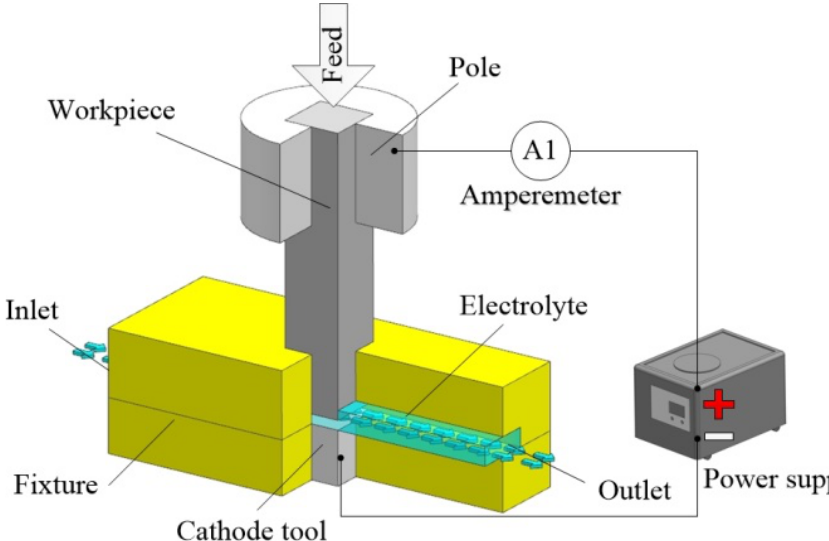
Figure 1. Schematic diagram of the conventional constant voltage method. During the measurement, the high-velocity electrolyte is pumped into the inter- electrode gap, so that bubble and Joule heat can be quickly removed to ensure the purity of the electrolyte. The tool and workpiece are connected to the cathode and anode of the power supply, respectively. The power supply outputs a constant voltage. The current distribution on the anode workpiece can be assumed as uniform based on the use of an electrode with flat end. The cathode tool is fixed in the fixture and static, while the anode workpiece is moved relative to the cathode tool at a constant speed. Under the electrochemical reaction, the anode material dissolves into the electrolyte. The dissolution rate v a is given by Faraday’s